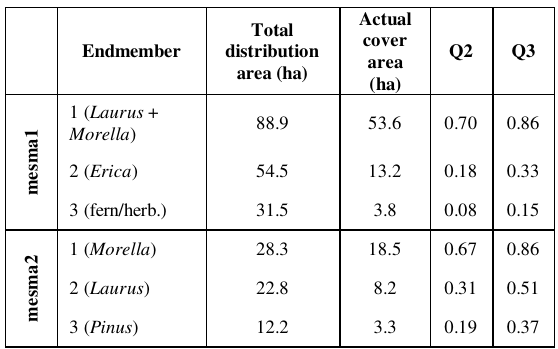
Overall species distribution areas obtained after mesma1 and mesma2. The total distribution area is derived from the total number of cells where the species were detected, whereas the actual cover area takes into account the species cover fraction in each cell as well. Q2 and Q3 correspond to the 50 th and 75 th percentile respectively.